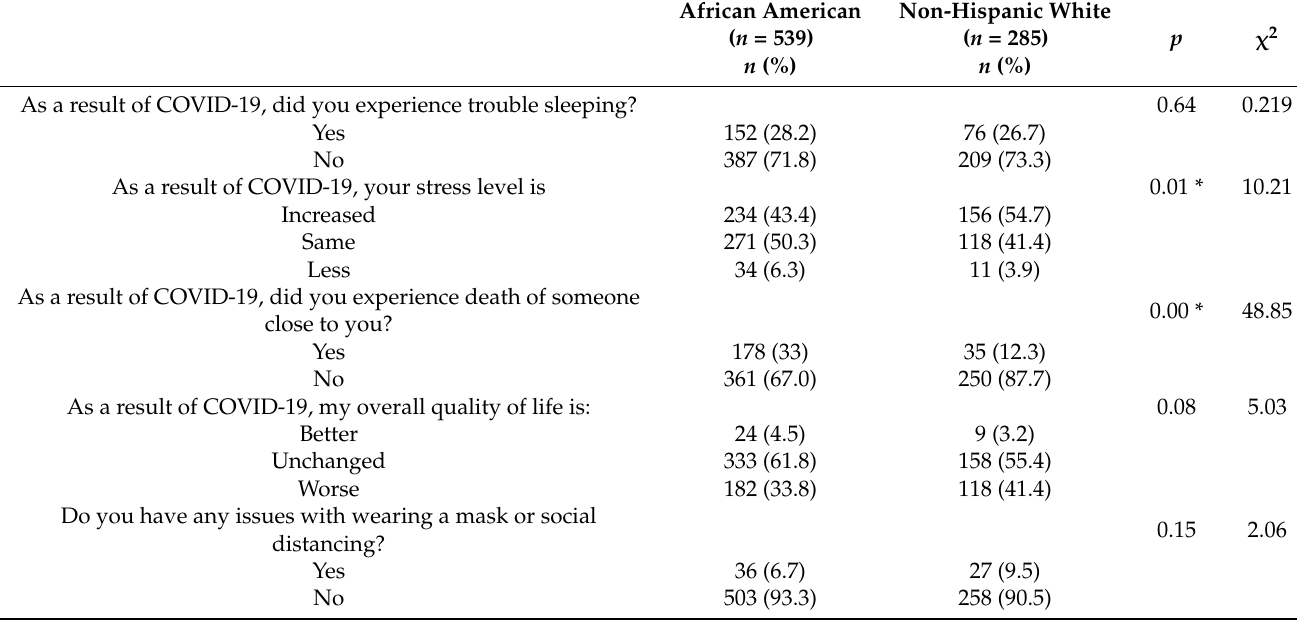
Table 3. COVID-19 psychosocial variables by race/ethnicity ( N =